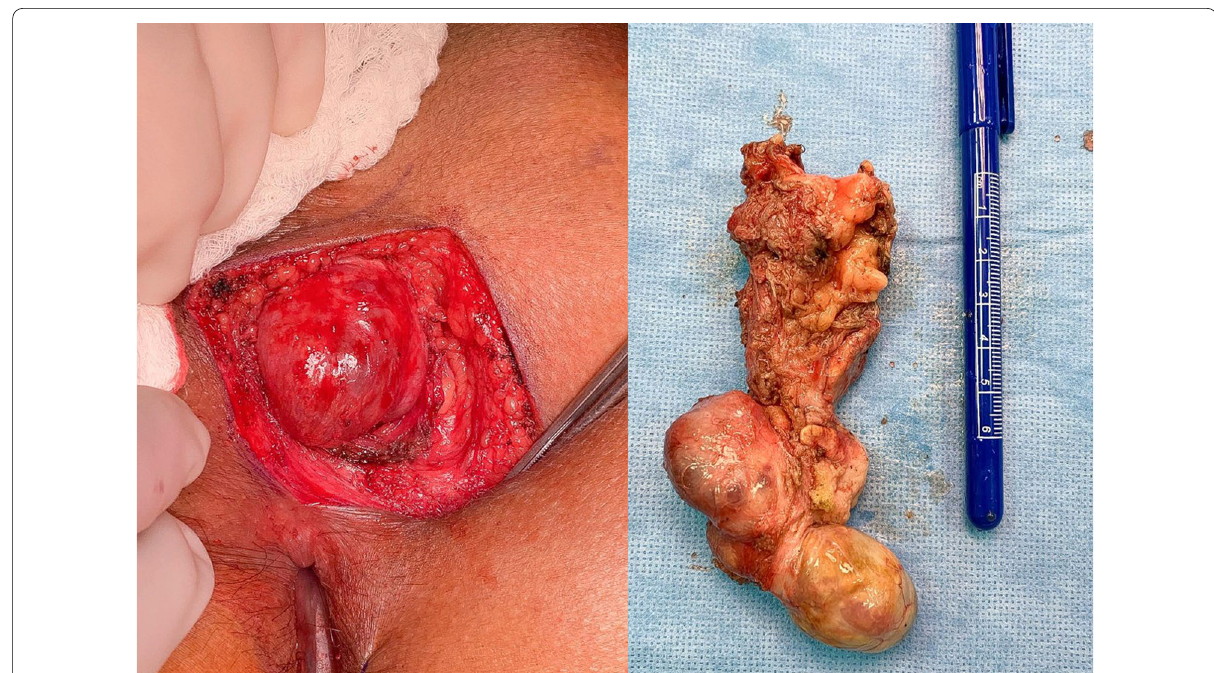
Fig. 4 Paracoccygeal skin incision to access to the presacral space. The mass was identified and dissected carefully of the surrounding tissues and removed in single